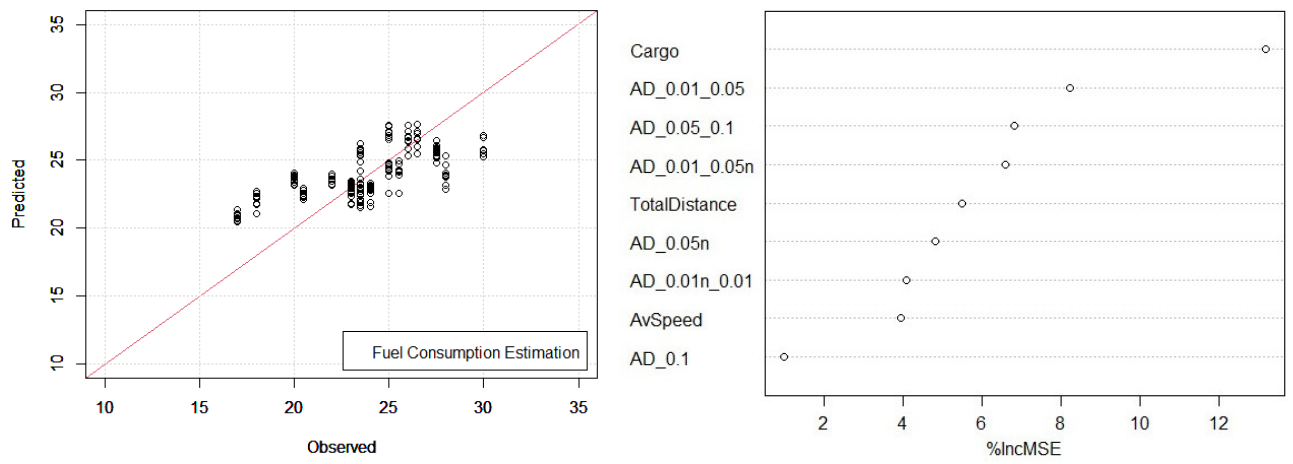
Figure 8. Prediction model